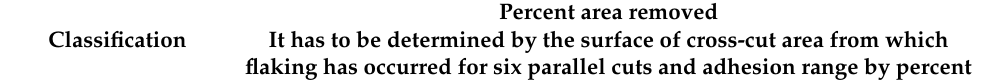
Table 4. Classification of the cross-cut test (on the basis of [48]).